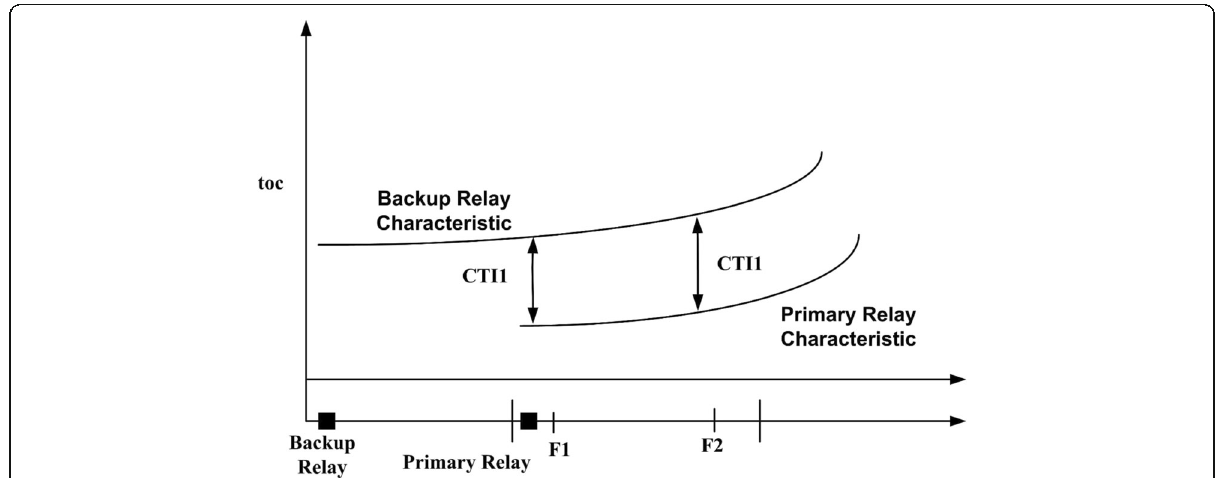
Fig. 1 Over current to over current relay